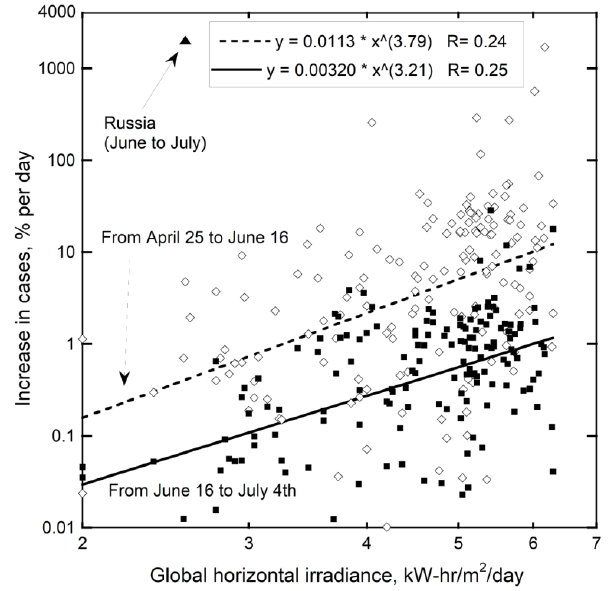
Figure 7. Logarithmic plot demonstrating that case increases per day, for each the spring and summer correlate with median total solar irradiance. COVID-19 data from [46,53]. The maximum and minimum GHI reported for each country on the Global Solar Atlas website [89] were averaged. Diamonds = all countries over late spring. Filled squares = increase over the summer solstice. The extreme increase in Russia occurred just after the record-breaking temperature highs in Siberia in June.